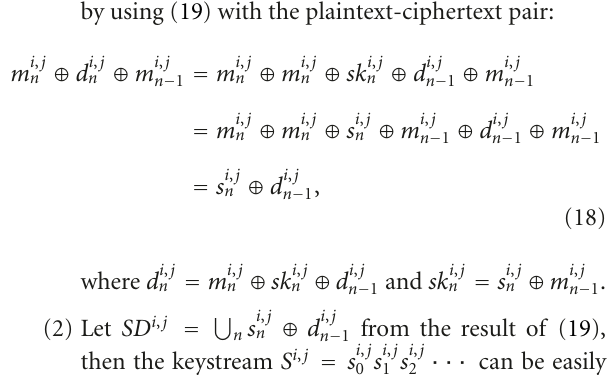
obtained some plaintext-ciphertext pairs. The attack